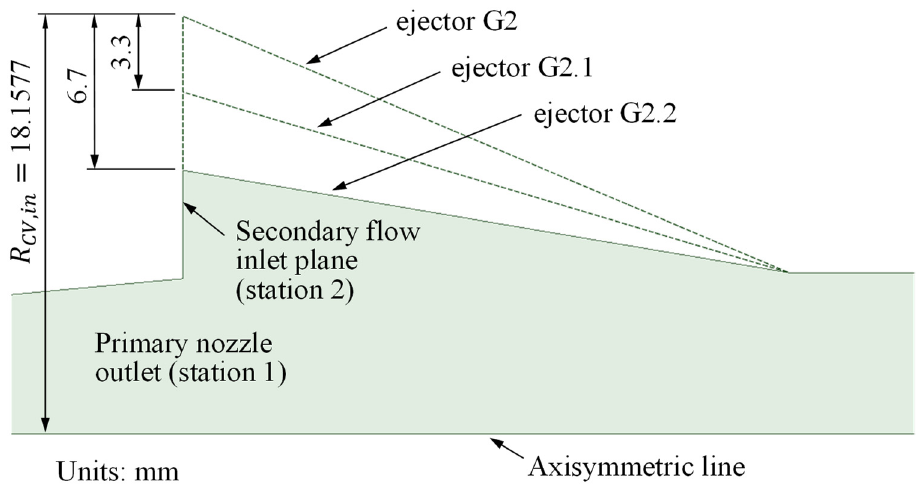
Figure 5. The variation in ejector geometry for the parametric